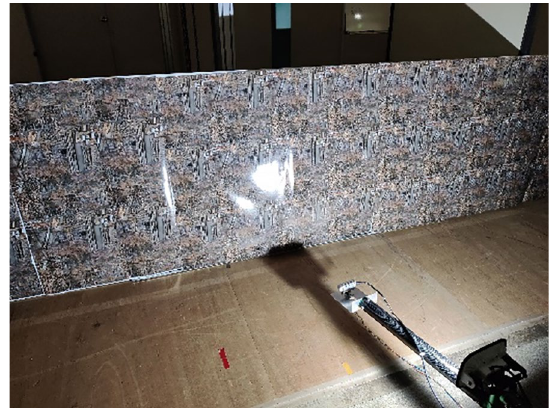
Fig. 17 Illumination condition variation 3 with LED illumination device mounted on